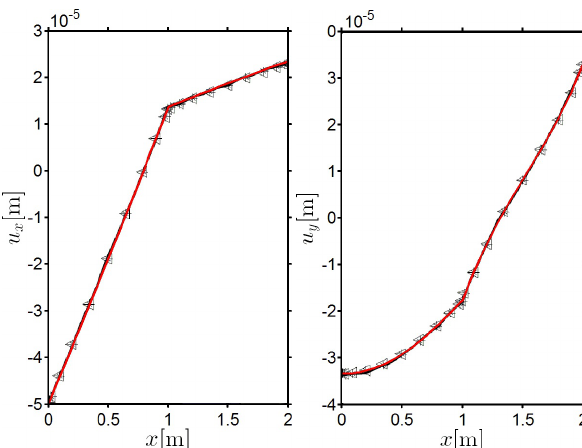
Figure 12: The present result using N = M = 21 for each